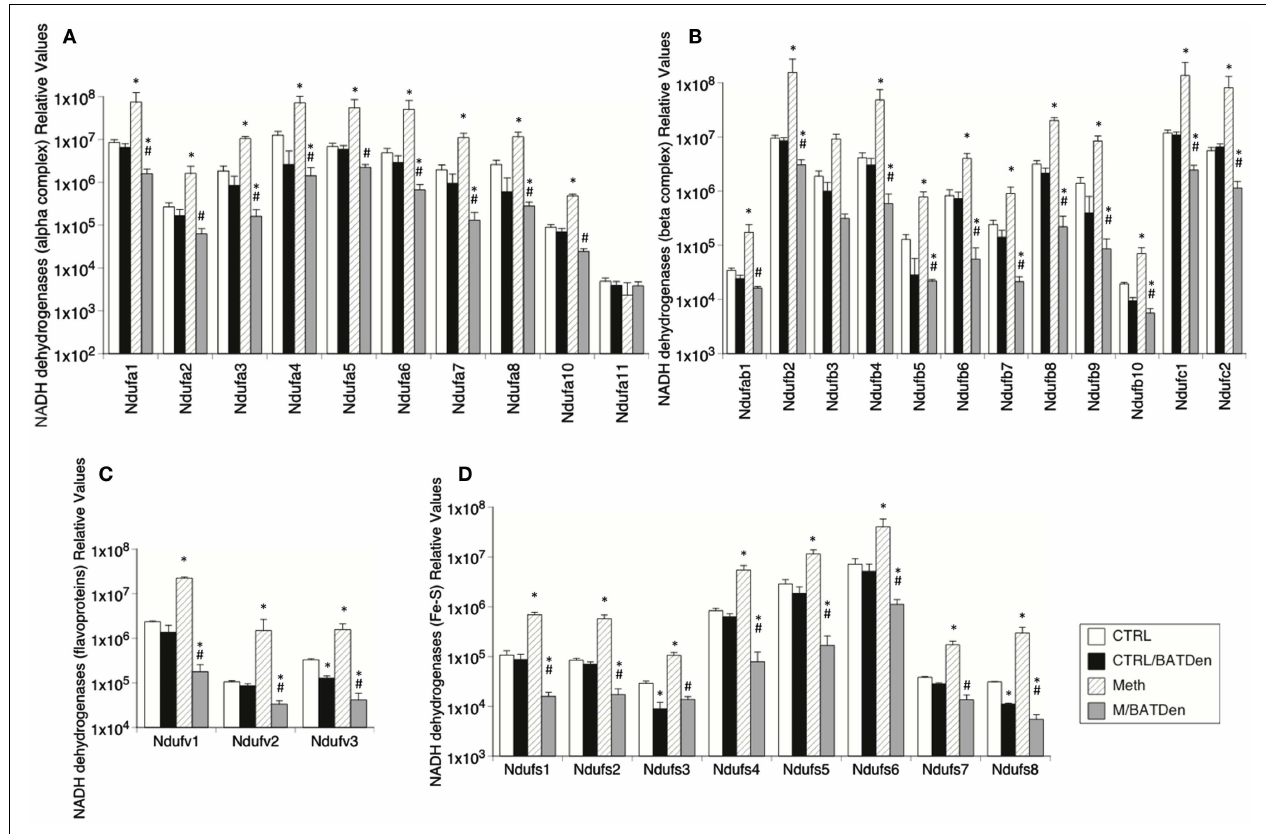
dehydrogenases, (B) beta complex NADH dehydrogenases, (C) Flavoprotein-NADH dehydrogenases, and (D) Fe-S NADH dehydrogenases. Values represent the average ± SEM of six animals/group. * p < 0.05 Compared to respective control, # p < 0.05 compared to Meth